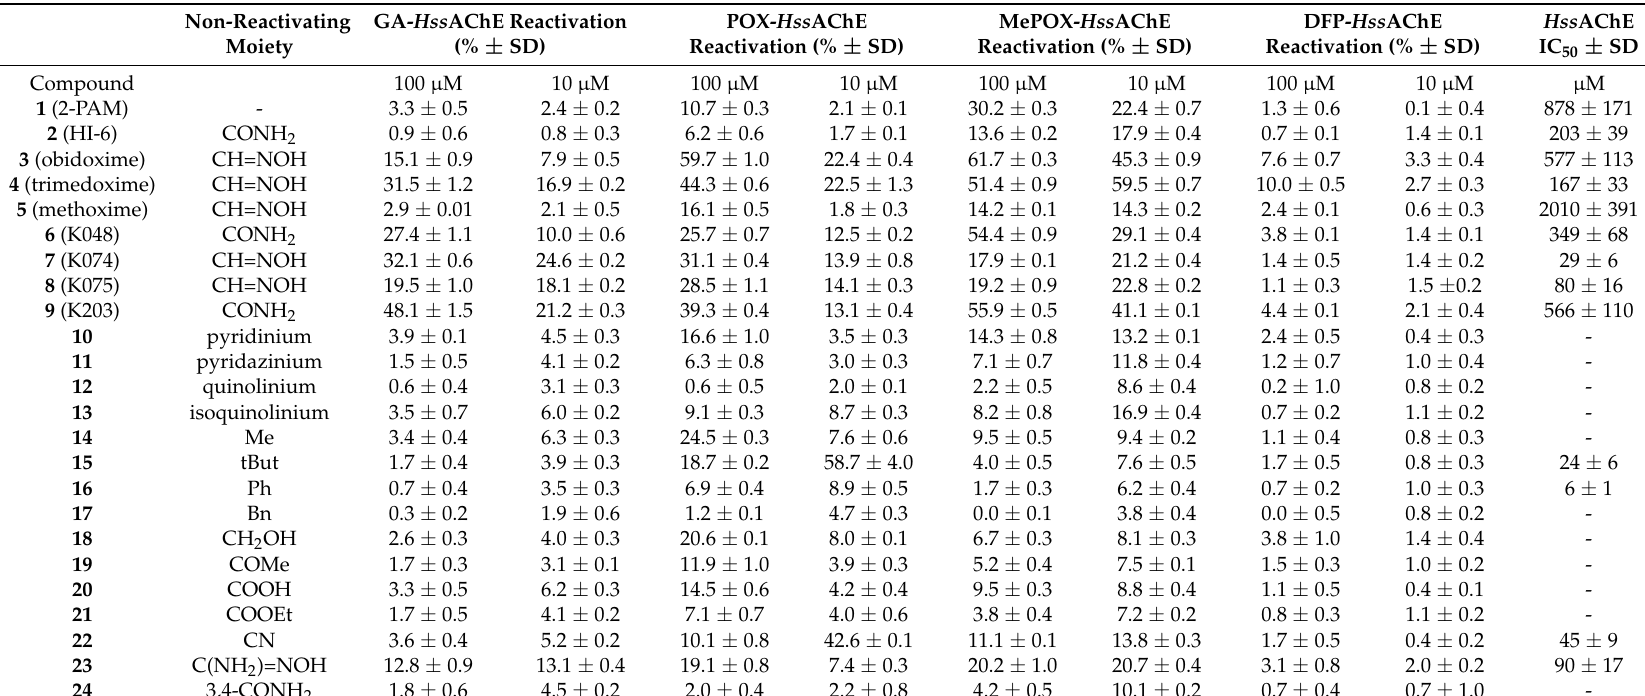
Table 1. Reactivation results of commercial, formerly published and newly prepared AChE